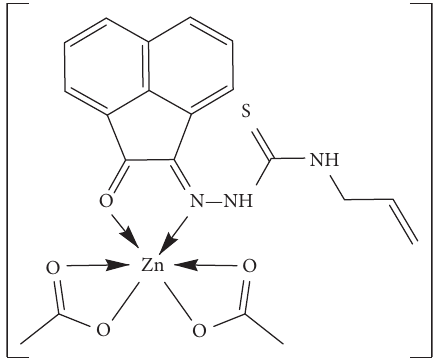
Figure 4: Suggested structure of Zn(II)